Question: What caption would you write for this figure?
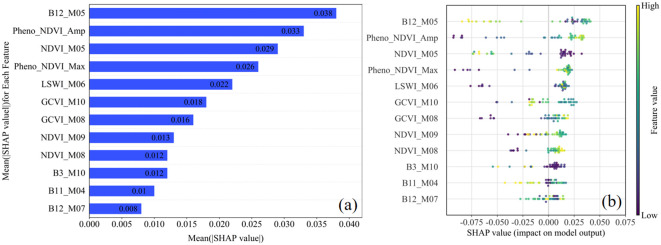
Answer: SHAP-based interpretation of feature importance for Random Forest model. (A) Global feature importance ranking, computed as the mean absolute SHAP value across all samples. (B) SHAP beeswarm plot, showing the distribution of SHAP values for each feature and their influence on model predictions, with points color-coded by feature value (purple: low; yellow: high).